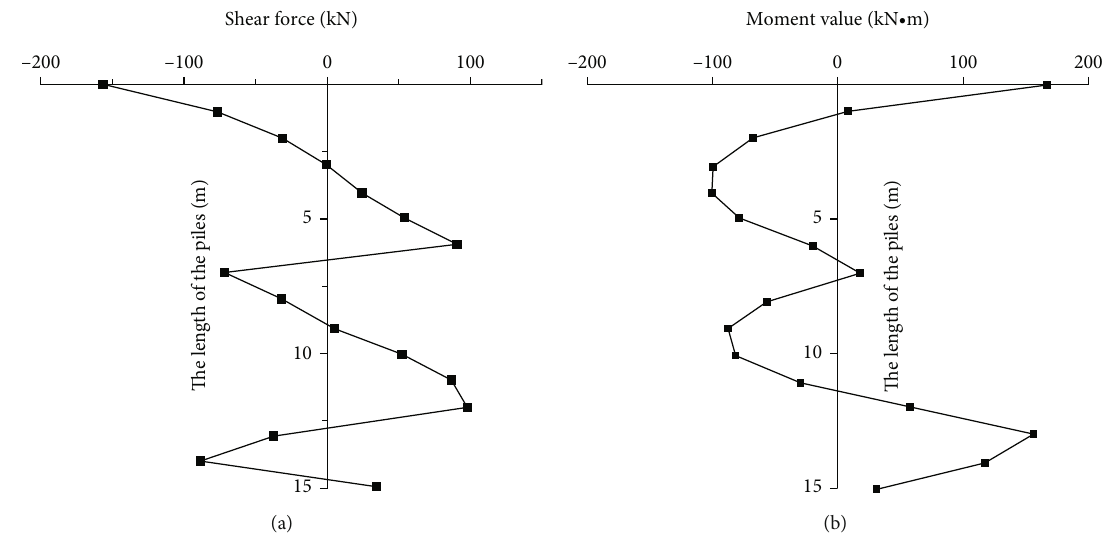
Figure 15: Shear force and bending moment curve of supporting pile. (a) Shear force curve of supporting pile. (b) Bending moment curve of supporting